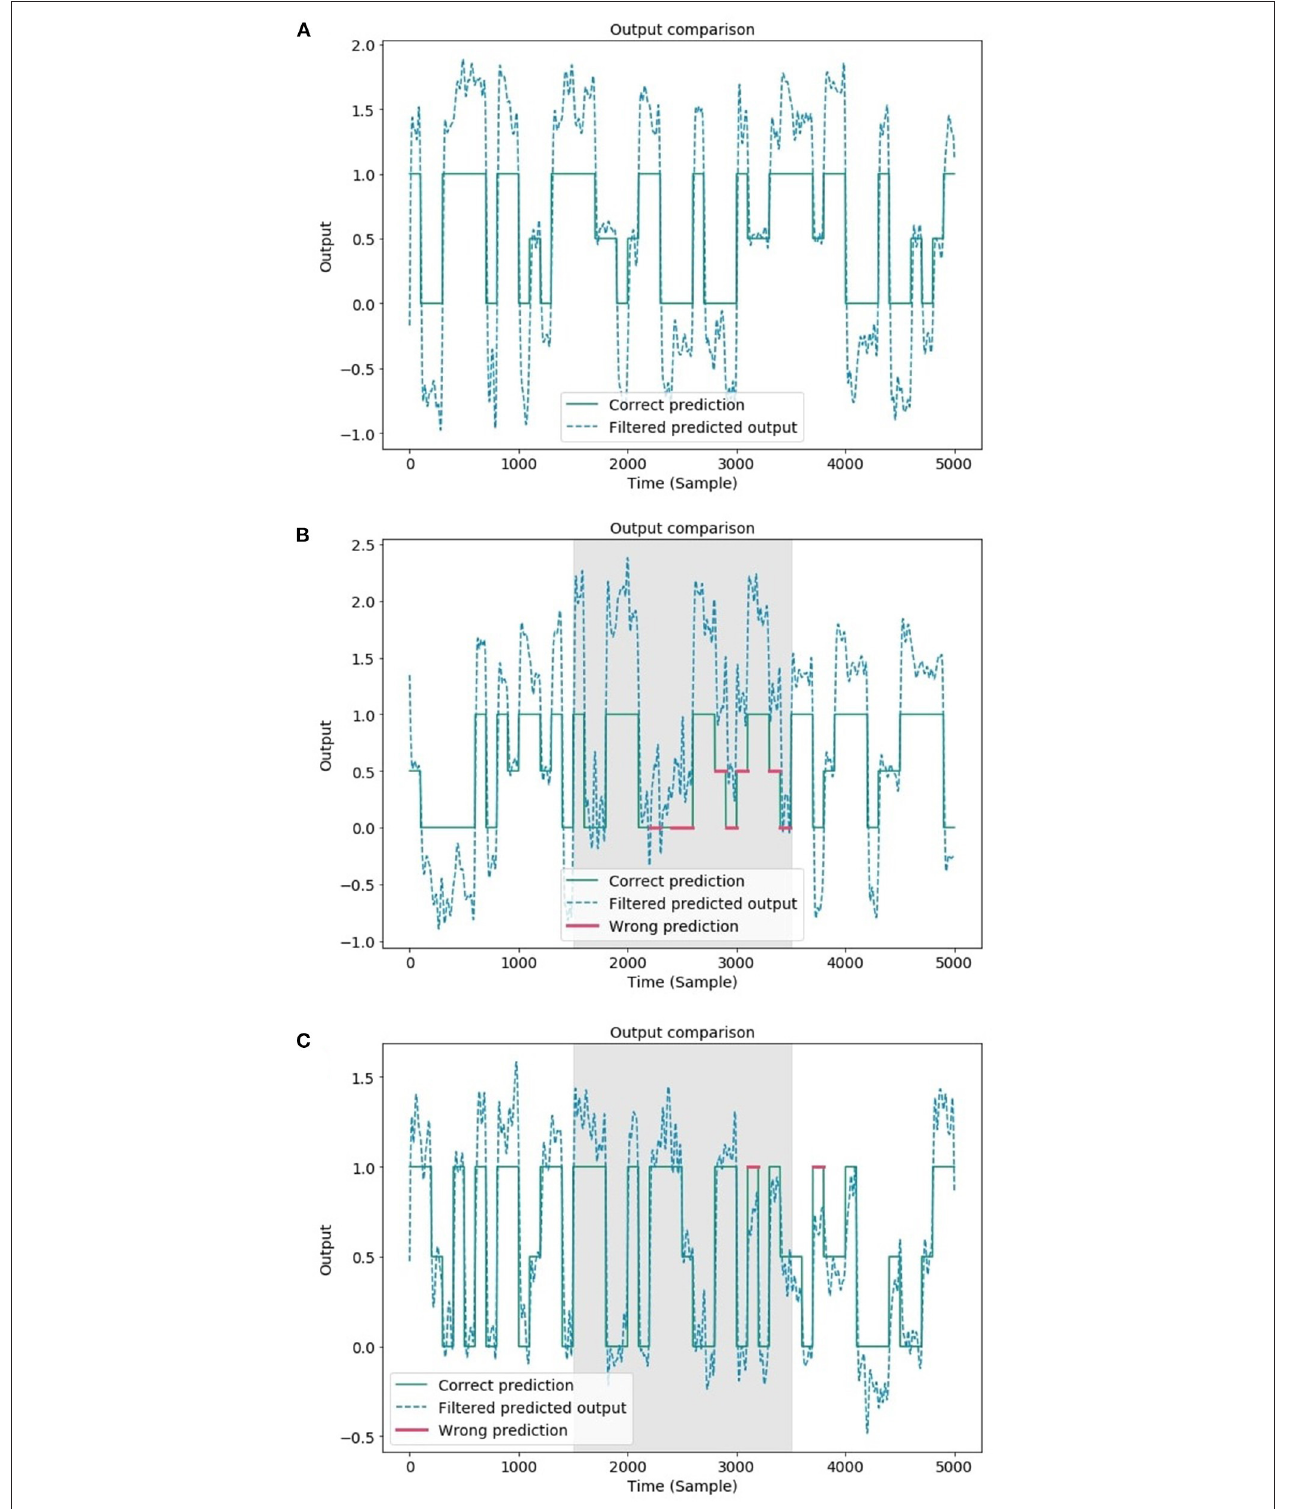
FIGURE 11 | Comparison between the filtered predicted output and the target signal obtained for different data configurations: learning without faults and testing without faults (A) , learning without faults and testing with faults (B) , and learning with faults and testing with faults (C) . The fault consists of the unavailability of the sensory signals coming from the front right leg (Hip2 and Knee joints) for 2,000 samples (gray area).